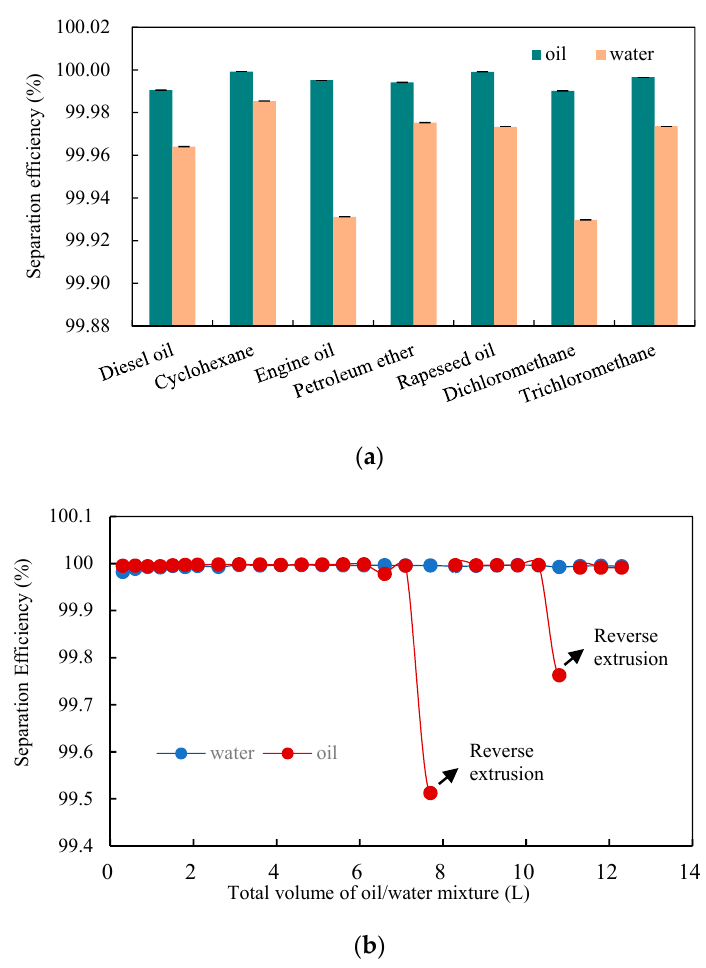
Figure 9. Separation efficiency of oil/water mixture. ( a ) Separation efficiency of different kinds of oil/water mixture; ( b ) separation efficiency of diesel and water mixture filtered continuously.